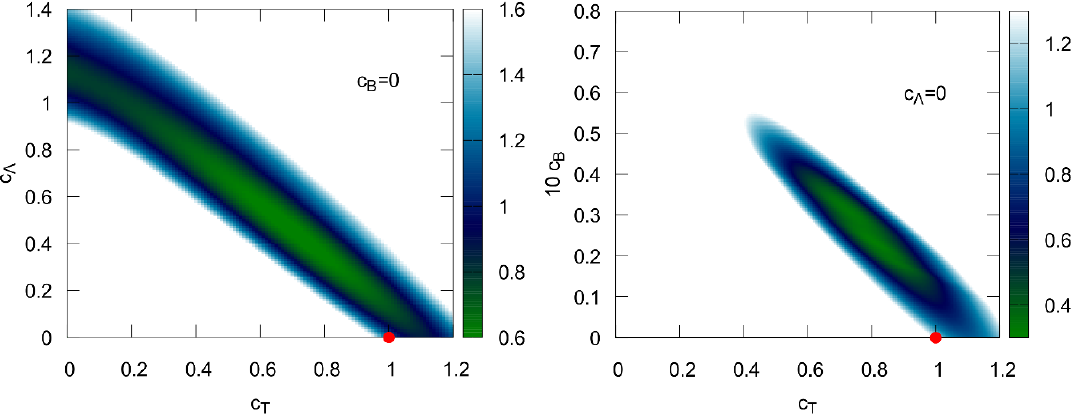
Figure 3 . Heat map of the deviation from universality, D , as a function of c T and c (cid:3) for (cid:12)xed c B = 0 (left panel), and as a function of c T and c B for (cid:12)xed c (cid:3) = 0 (right panel). The red dot indicates the choice of (cid:22) = T . The uncertainty in the value of D is of order unity. Inside the dark colored regions, where D . 1, universality holds to within the error bars of the lattice